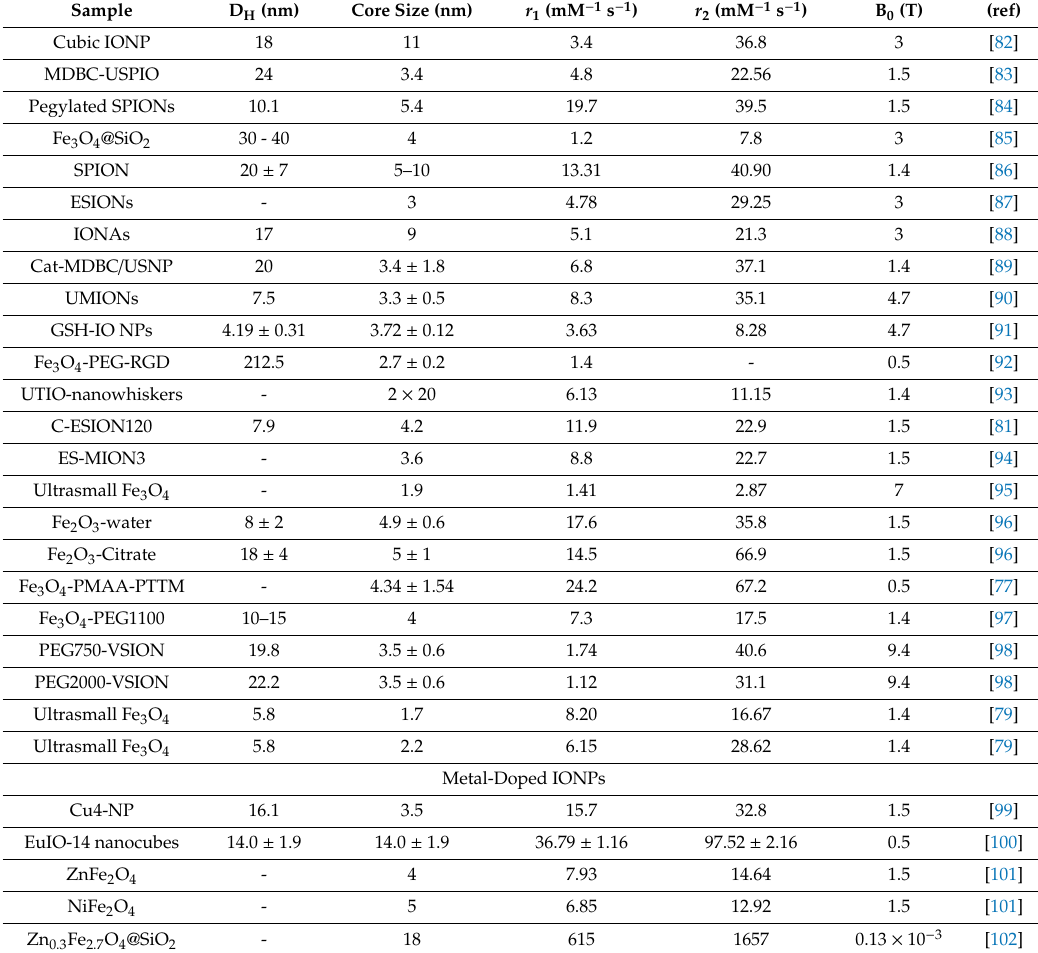
Table 3. Hydrodynamic diameter (D H , nm), core size (nm) and r 1 , r 2 (mM − 1 s − 1 ) at magnetic field B 0 (T) of reported T 1